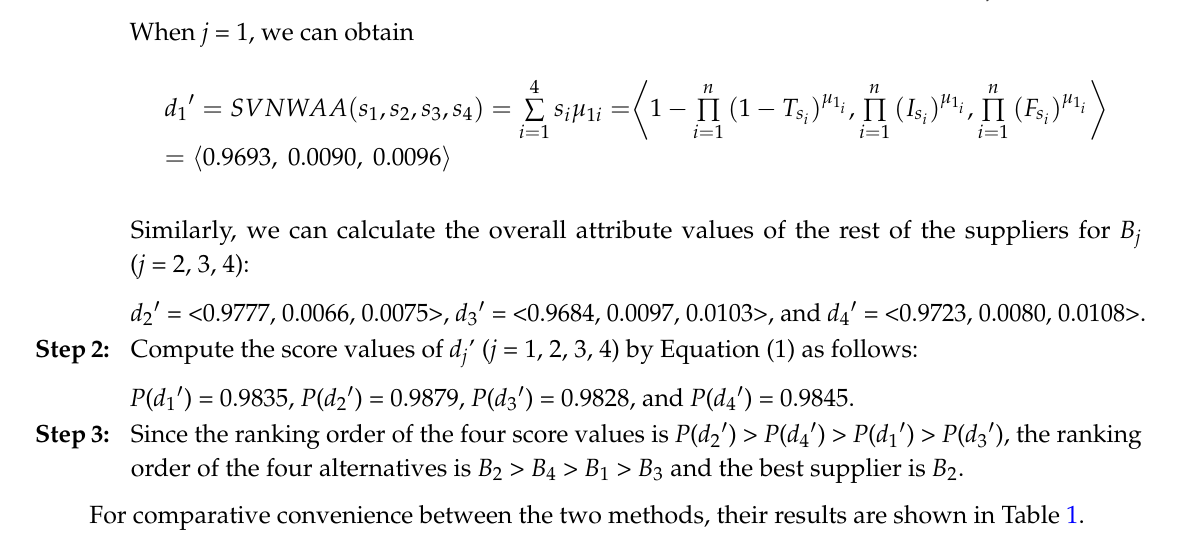
Table 1. The results of the two decision-making